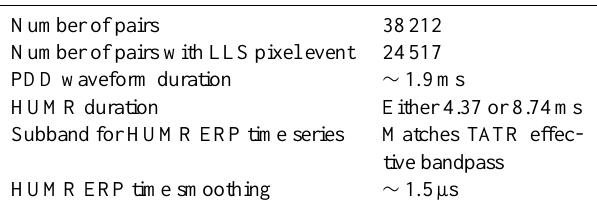
Table 2. HUMR–PDD waveform pairs with PDD control of HUMR trigger.